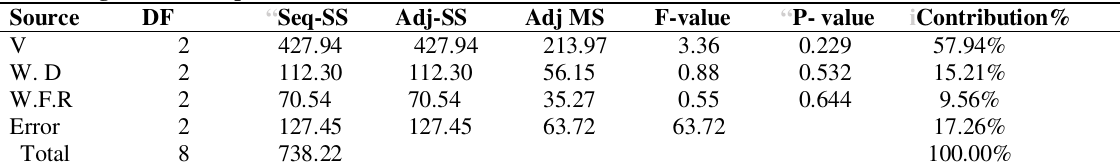
The average of each